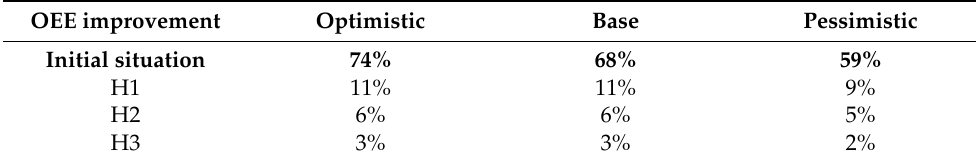
Table 5. Improvement in OEE according different scenarios and hypothesis. OEE